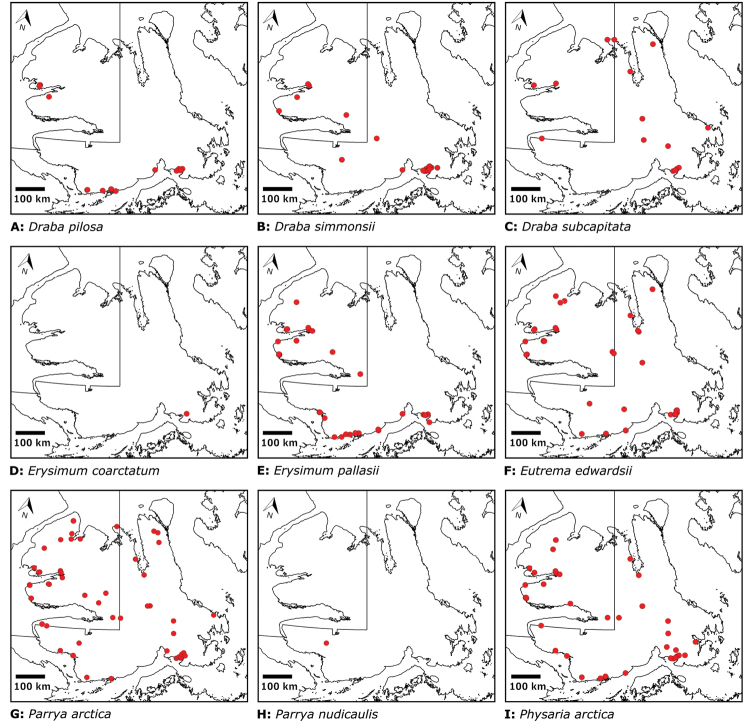
Species distribution maps. Brassicaceae: ADraba
pilosaBDraba
simmonsiiCDraba
subcapitataDErysimum
coarctatumEErysimum
pallasiiFEutrema
edwardsiiGParrya
arcticaHParrya
nudicaulisIPhysaria
arctica.